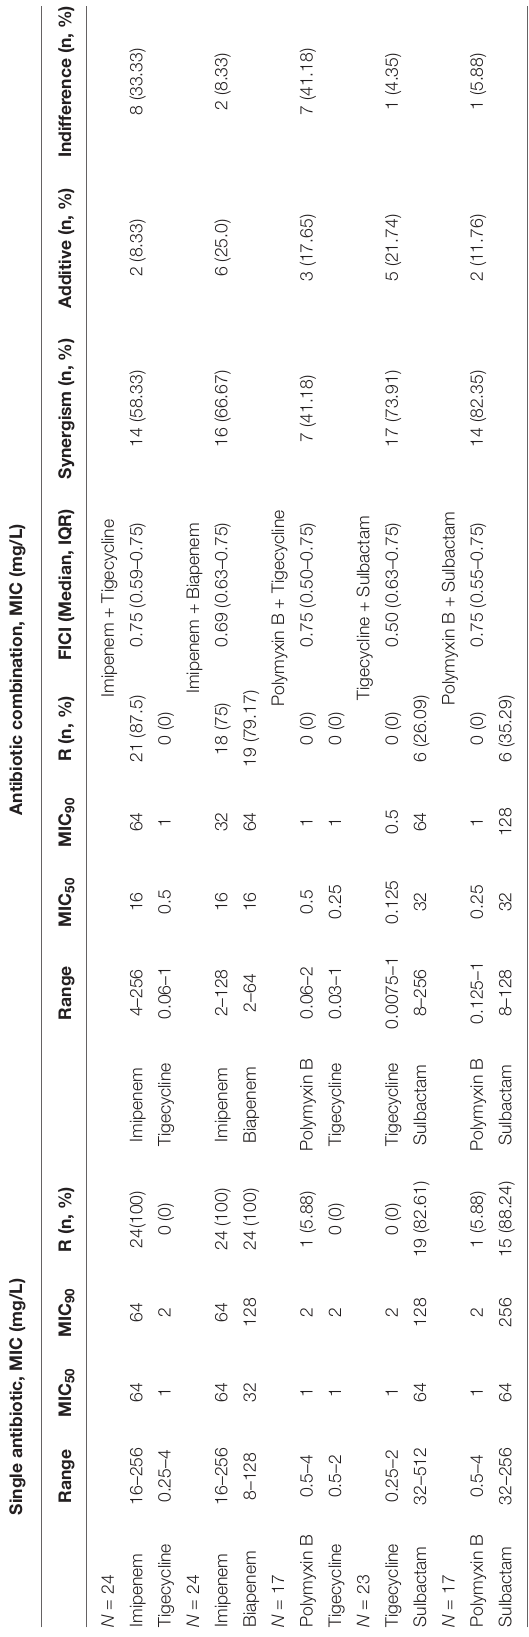
The in vitro Antibacterial Activity of Antimicrobial Combination in CRAB With Different Resistance Mechanisms The synergistic effect of PB in combination with SUL was higher than that of the other drug combinations against CRAB strains ( P < 0.05). In the strains with carbapenemases, the synergistic effect of the SUB-based combination was higher than that of PB- TGC combination ( P < 0.05). For other resistance mechanisms, in the synergistic effect ( P > 0.05) (see Table 3 ). Clinical Characteristics of Patients With CRAB Infection After excluding 4 patients with non-carbapenemase-producing CRAB infection, a total of 82 patients with CRAB infections (mean age 58.05 ± 17.54 years; 51 male) were included in this study ( Table 4 ). The treatment failure rate was 28.05% (23/82) within 28 days of the specimens being taken. Patients at an advanced age, those with multiple organ dysfunction syndromes (MODS), and those admitted in the ICU had a higher rate of treatment failure ( P < 0.05). Patients in the treatment failure group had higher levels of procalcitonin (PCT) and percentage of neutrophils, and a lower level of estimated glomerular filtration rate (eGFR) than those in the treatment success group ( P < 0.05). The treatment failure group had a higher proportion of CRAB patients with bloodstream infections than the treatment success group ( P < 0.05). More patients had a poor clinical outcome even if they were given appropriate antibiotic therapy ( P < 0.05). Patients infected with CRAB strains with lower MICs of TGC had a better clinical outcome ( P = 0.021). Risk Factors for a Poor Treatment Outcome of Patients With CRAB Infection Multivariate analysis showed that ICU stay (OR = 15.123, 95% CI: 2.600–87.951, P = 0.002) and PCT ≥ 2 ng/ml (OR = 2.636, 95% CI: 1.173–5.924, P = 0.019) were independent risk factors for treatment failure in patients with CRAB infection, as shown in Table 5